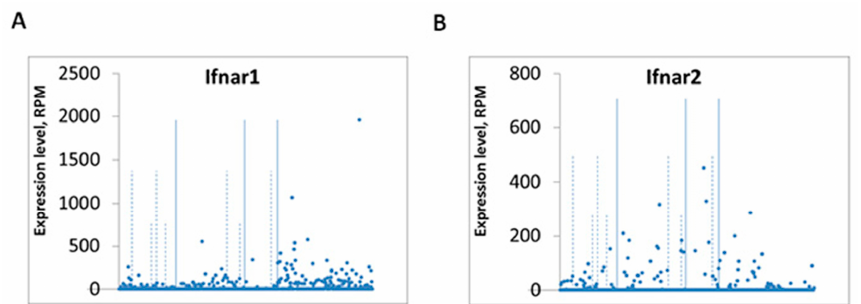
Figure 4. Single-cell RNAseq showing the expression of Ifnar1 ( A ) and Ifnar2 1 ( B ) in different populations of mouse DRG neurons. Search engine of scatter plots of expression, reads-per-million (RPM), for any gene in 622 neurons assigned to individual populations. Values are grouped along the horizontal axis according to identified populations. Solid vertical lines separate major sensory neuron types in the order: NF (neurofilament), NP (non-peptidergic), PEP (peptidergic), TH (tyrosine hydroxylase) populations. Dashed vertical lines separate major populations into further subtypes, for example, NF1 to NF5 for NF major type. Vertical axis shows normalized expression level in RPM (reads per million) for individual cells. Each dot represents one neuron. Plotted from the database of Usoskin et al., 2015 [99].